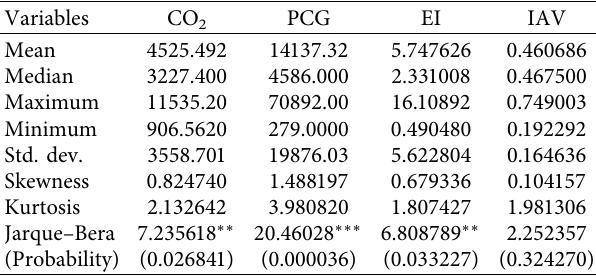
Table 1: Model notation and feature description. The time-varying parameter VAR with SV in TVP-SV (6), (8), and (9)